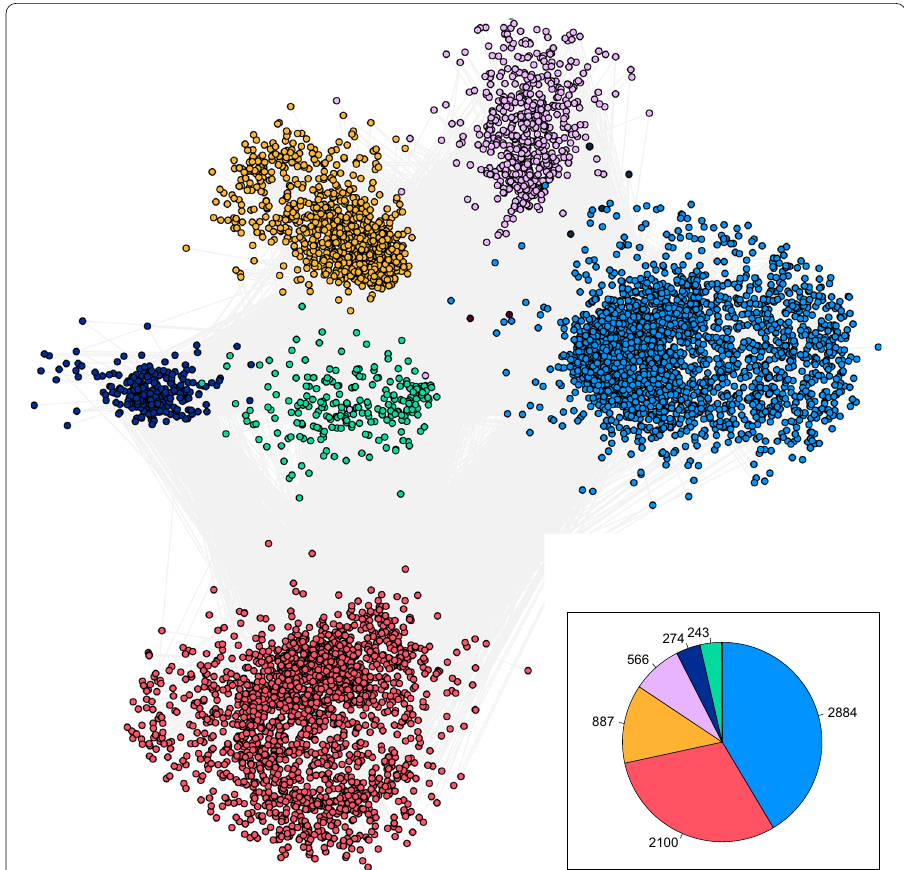
Fig. 5 Community structure on the I nstancEs network obtained by the directed Louvain method. The displayed layout is based on the force-directed drawing Fruchterman-Reingold model, with weight 150 for edges incident nodes in the same community and weight 1 for edges incident nodes in different communities. The pie-chart in the bottom-right corner shows the size proportion of the communities,